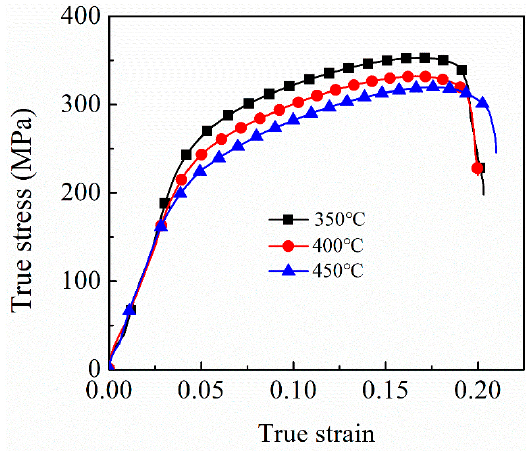
Figure 6. True tensile stress–strain curves of the extruded sheets fabricated by low-speed extrusion. Table 1. Mechanical properties of the extruded sheets fabricated by low-speed extrusion.